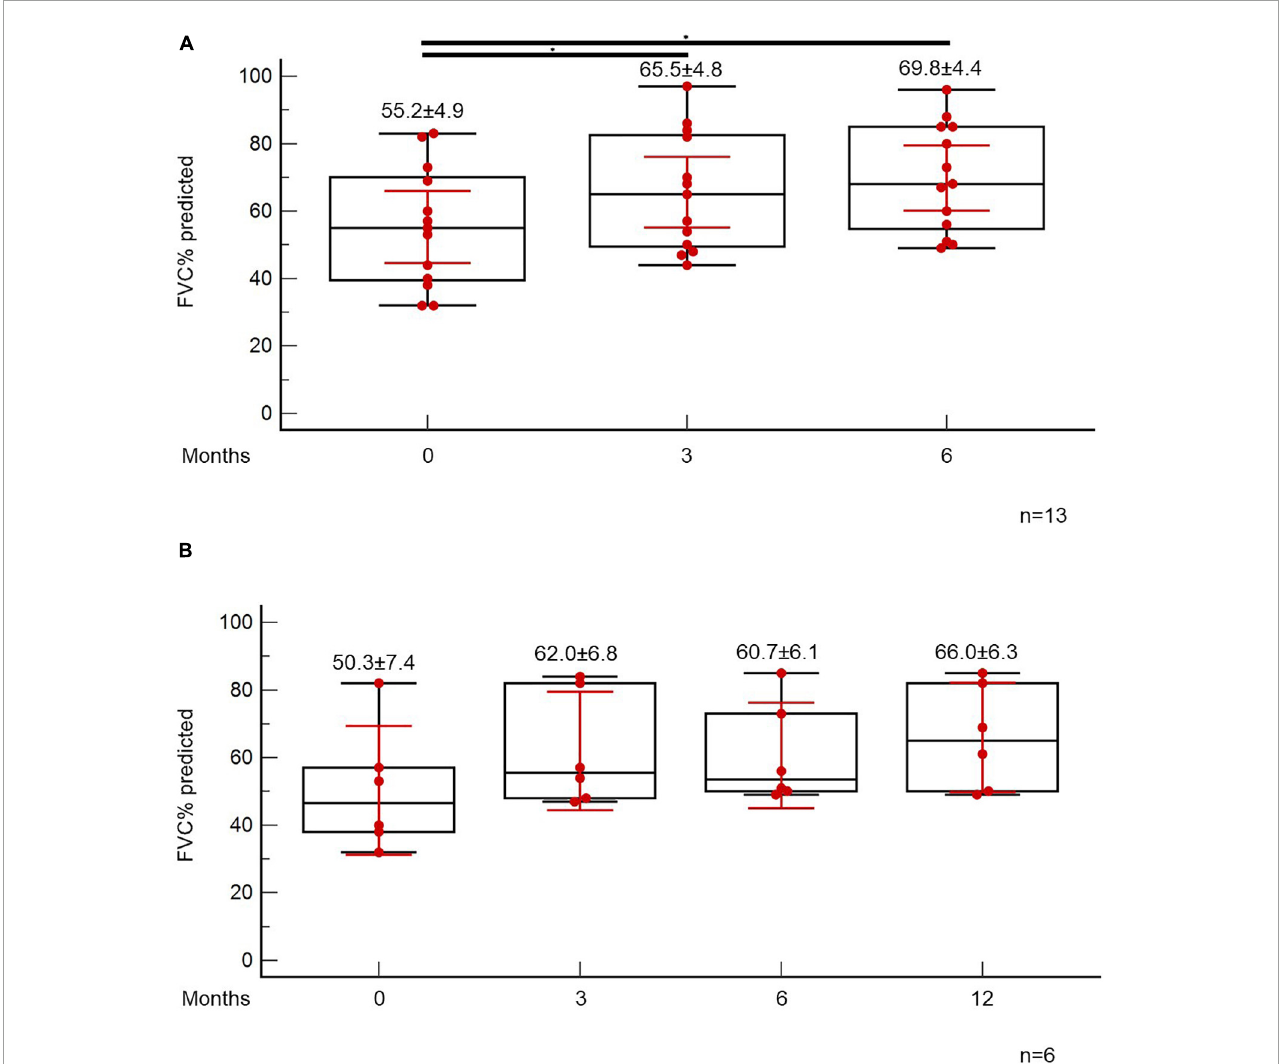
FIGURE5 Patients with fibrotic-like changes and persistently decreased functional indices received antifibrotics. ANOVA repeated measures was used to investigate differences in FVC% predicted at different time points (A) . Subgroup analysis of patients with 1-year follow-up is presented in panel (B)